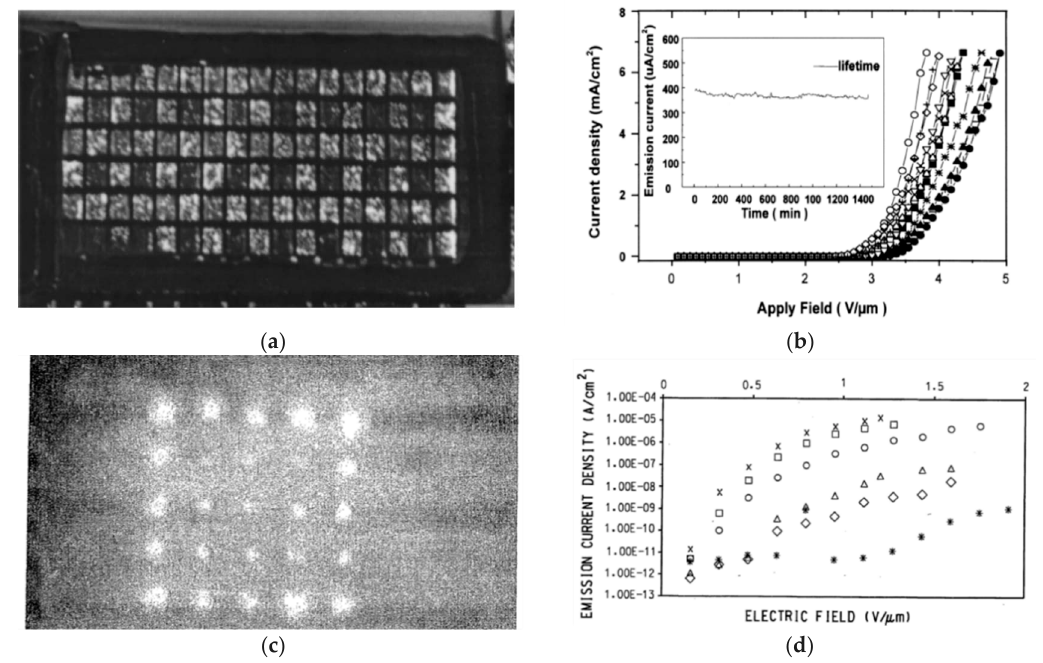
Figure 8. One of the first screen-printed CNT-FE arrays: ( a , c ) images of the light emitted from various phosphors by use of the screen-printed FE cathode arrays; ( b , d ) FE characteristics of several screen-printed CNT films; the inset in ( c )—a lifetime test showing the stability of the emission current. ( a , b ) reprinted with permission from [103]; ( c , d ) reprinted from [116].